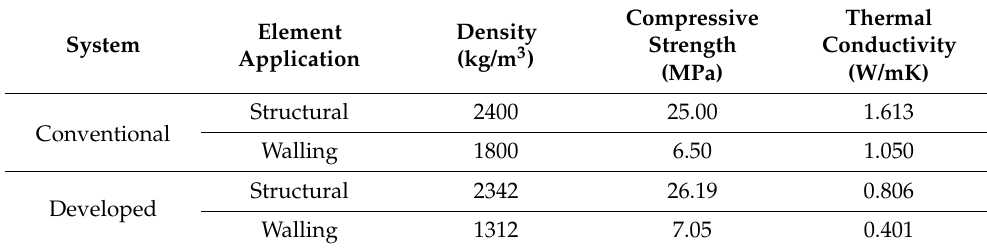
Table 5. Material properties of end